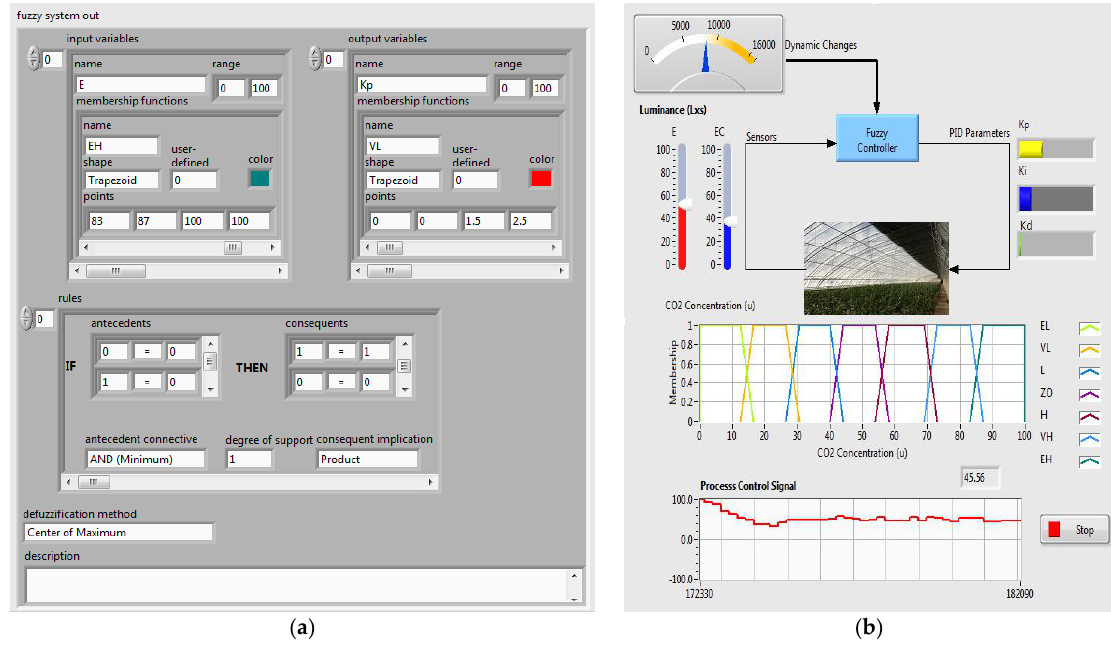
Figure 10. ( a ) Background dynamic Fuzzy-PID interface; ( b ) Interactive platform of the control module.